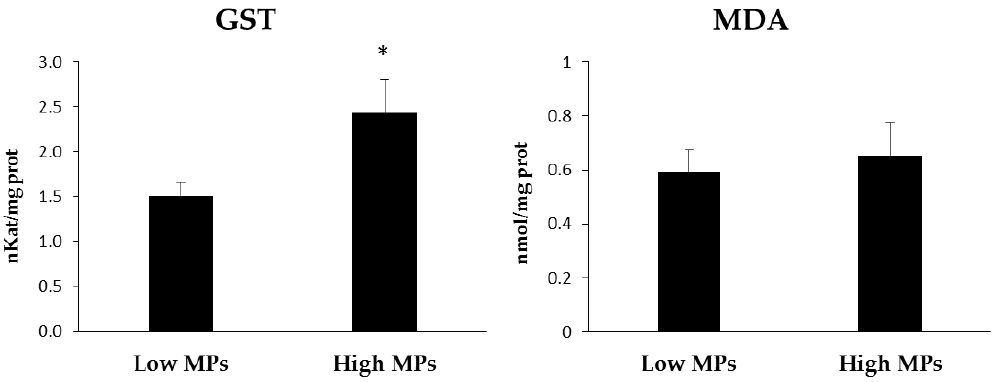
Figure 5. GST (glutathione S -transferase) activity and MDA (malondialdehyde) levels determined in the liver tissue homogenates of Xyrichtys novacula sampled in Eivissa (Balearic Islands, Spain). * indicates significant differences ( p < 0.05) between groups.